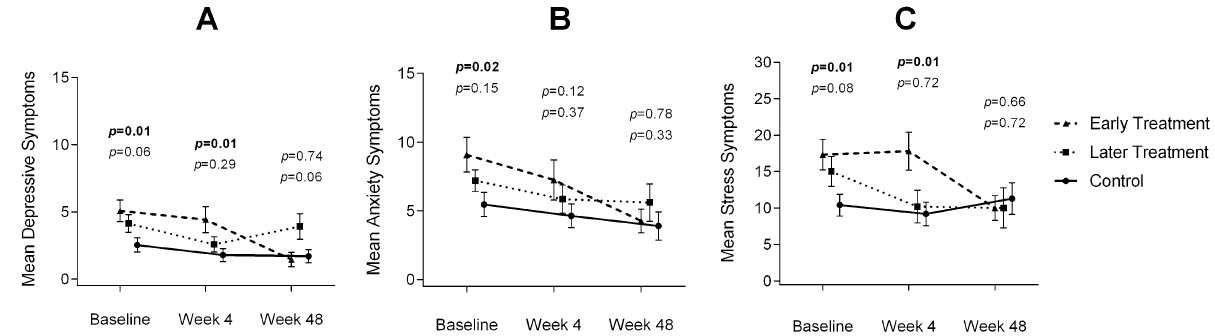
Figure 2. Progression of depressive, anxiety, and stress symptoms. The p values shown above indicate early treatment vs control comparisons. The p values shown below indicate later treatment vs control comparisons. The statistical test applied was ANOVA for means. Bold p values denote statistical significance. ( A ) Mean depression scores. Bars represent the standard error of the mean. ( B ) Mean anxiety scores. Bars represent the standard error of the mean. ( C ) Mean stress scores. Bars represent the standard error of the mean.